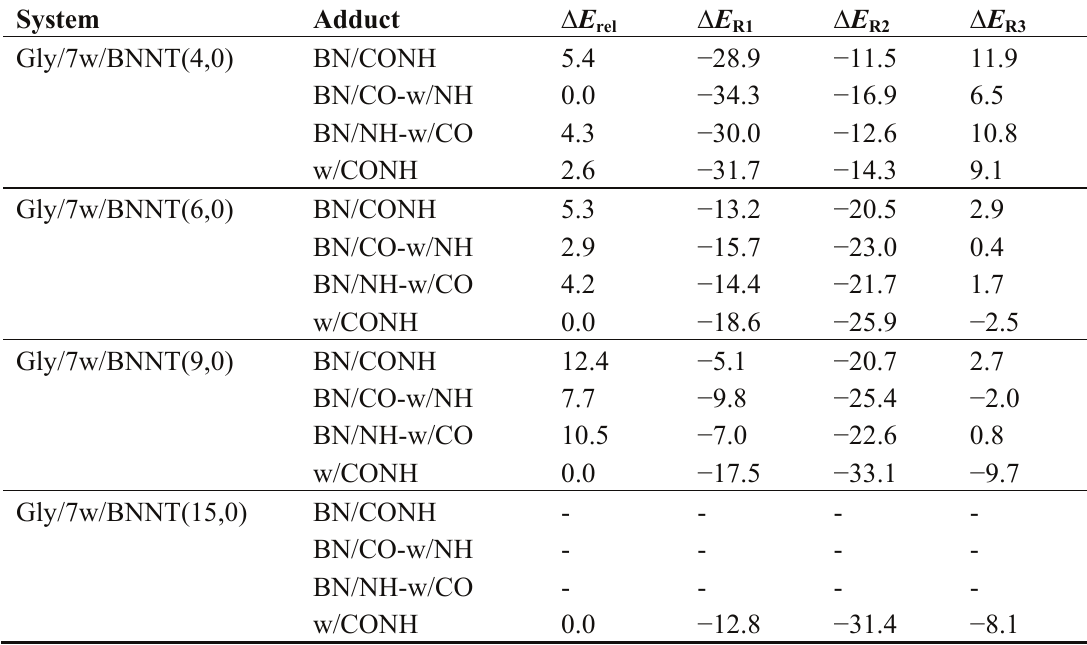
, ∆ E and ∆ E ) and relative energies ( ∆ E R1 R2 R3 rel